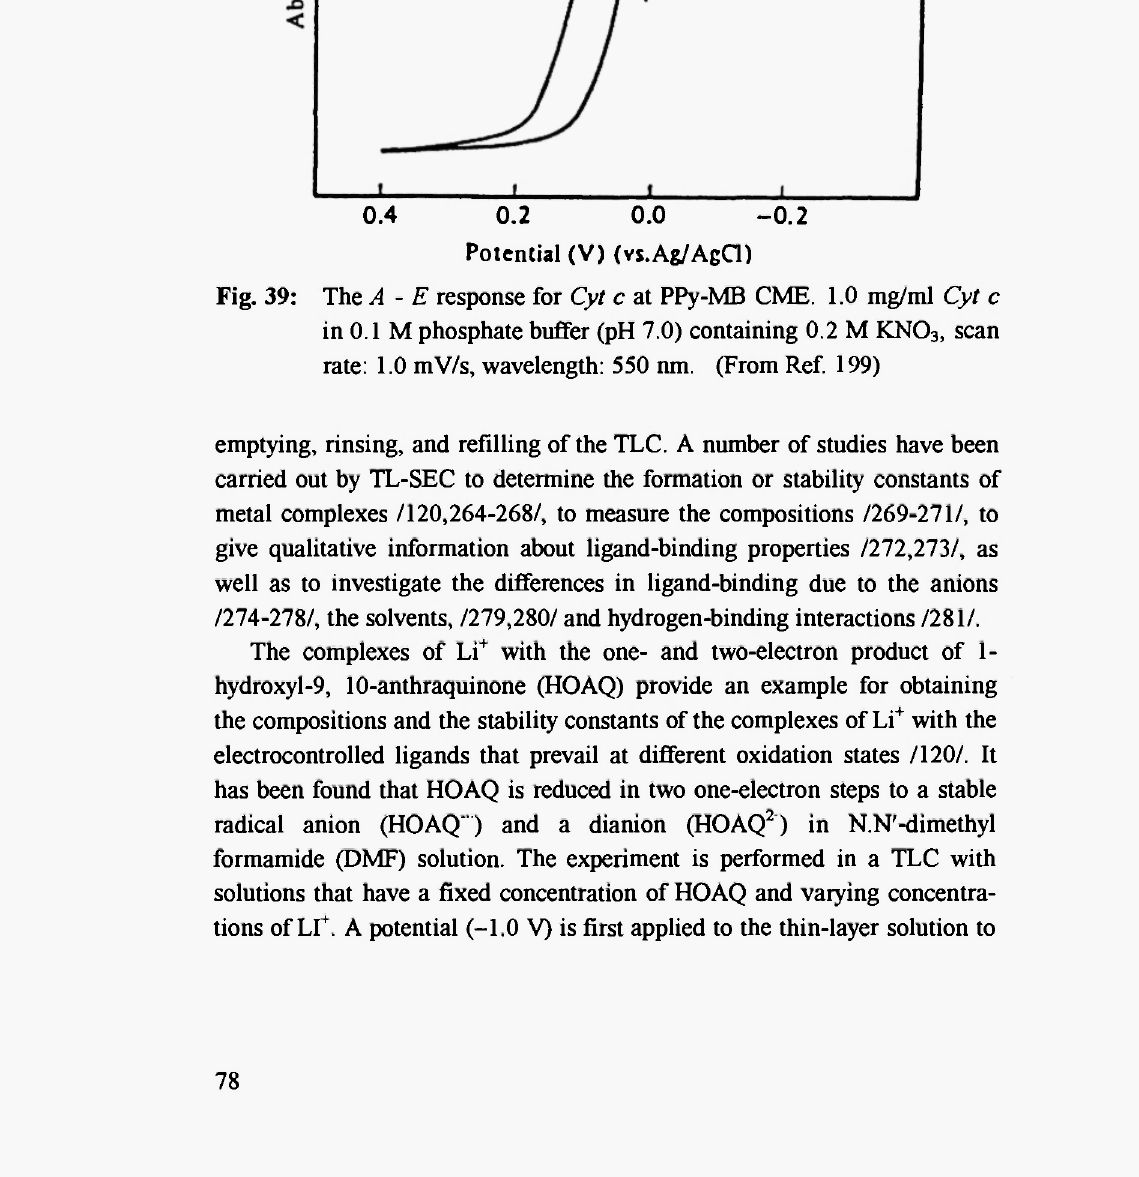
Fig. 39: The Α - Ε response for Cyt c at PPy-MB CME. 1.0 mg/ml Cyt c in 0.1 Μ phosphate buffer (pH 7.0) containing 0.2 Μ ΚΝ0 rate: 1.0 mV/s, wavelength: 550 nm. (From Ref.